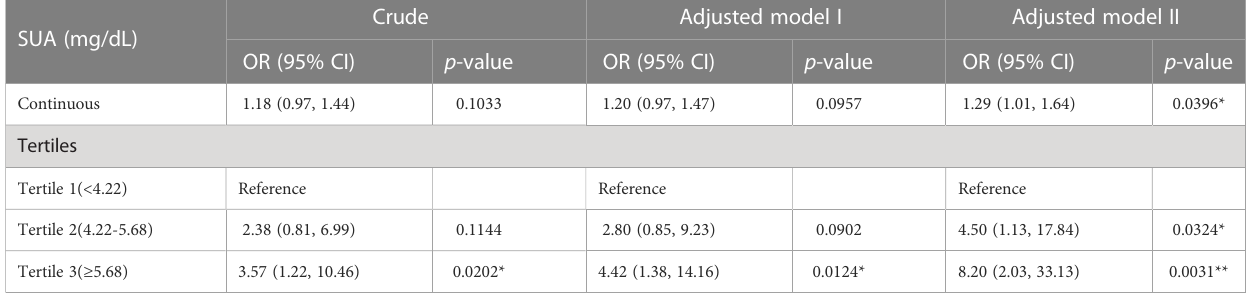
TABLE 4 The association of pretreatment SUA concentrations with vascular invasion (V+/P+).